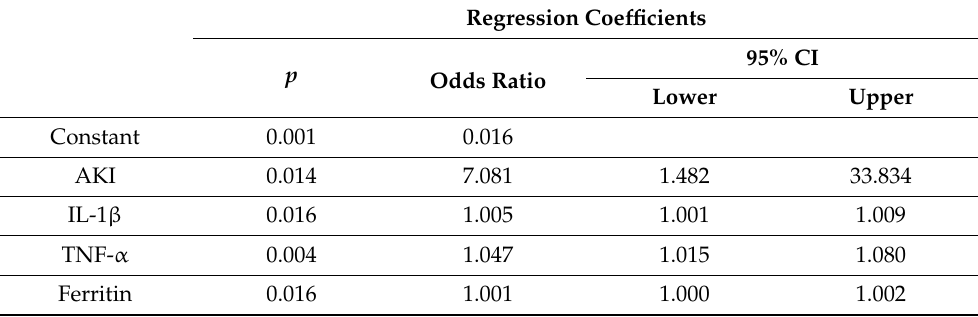
Table 4. Logistic regression analysis demonstrating the factors predicting mortality.